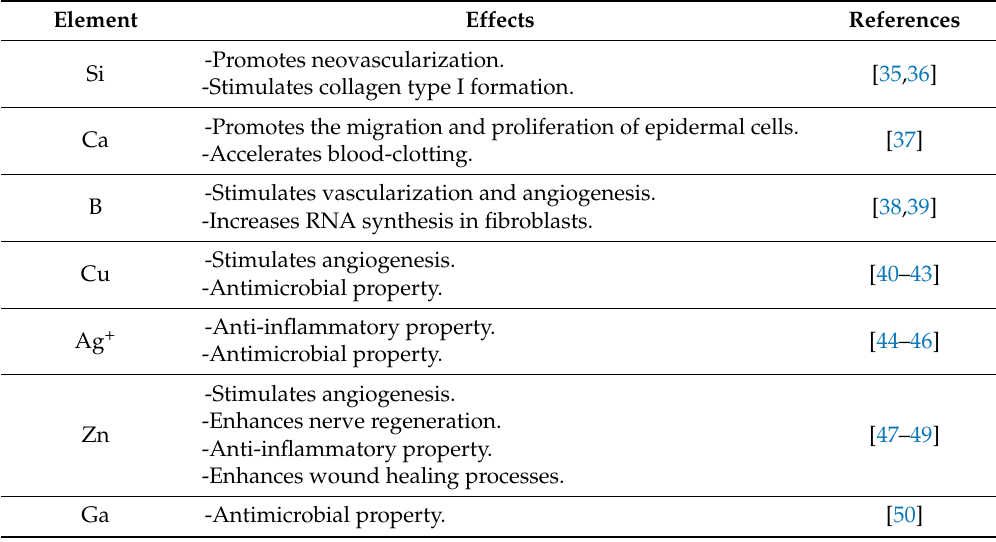
Table 1. ThemainionsreleasedfromBGsconsideredforsofttissueengineering(adaptedfromNaserietal.[34]). Element